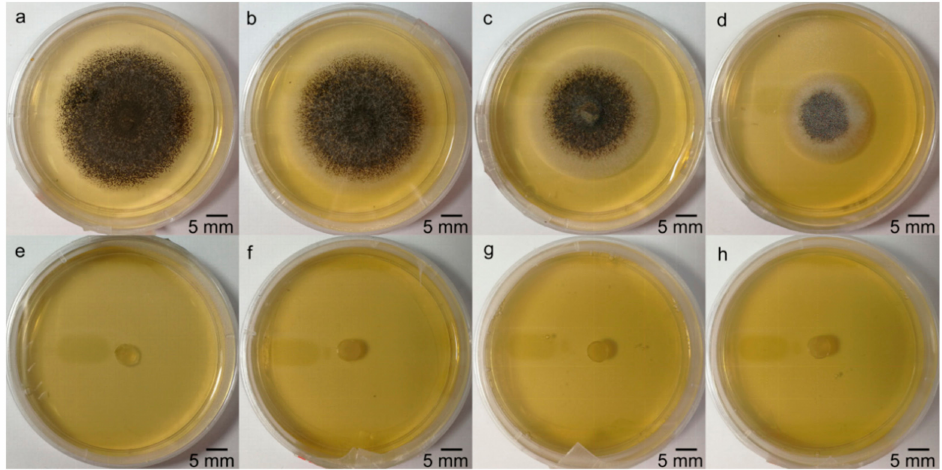
Figure 8. In vitro growth status of A. niger (4 days) under di ff erent concentrations of aqueous garlic extract (the Petri dish inner diameter is 55 mm). ( a ) control; ( b ) 1 mg / mL; ( c ) 2.5 mg / mL; ( d ) 5 mg / mL;